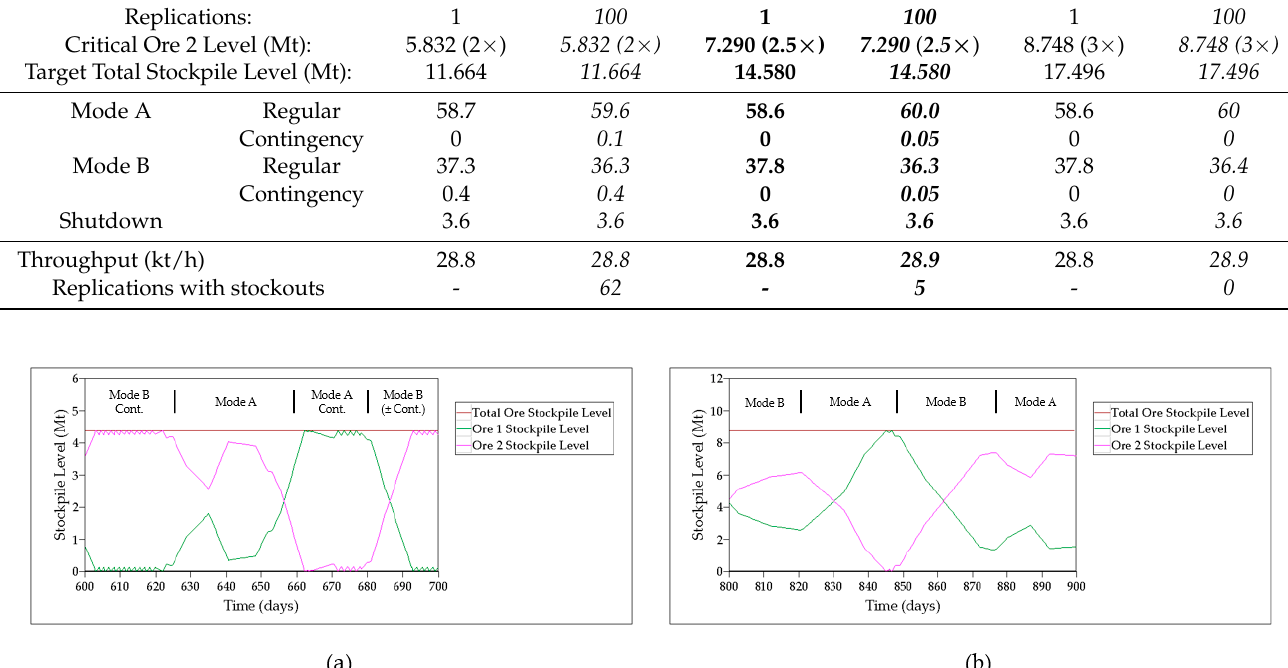
Table 8. Distribution of time spent in each mode type under varied critical ore levels.